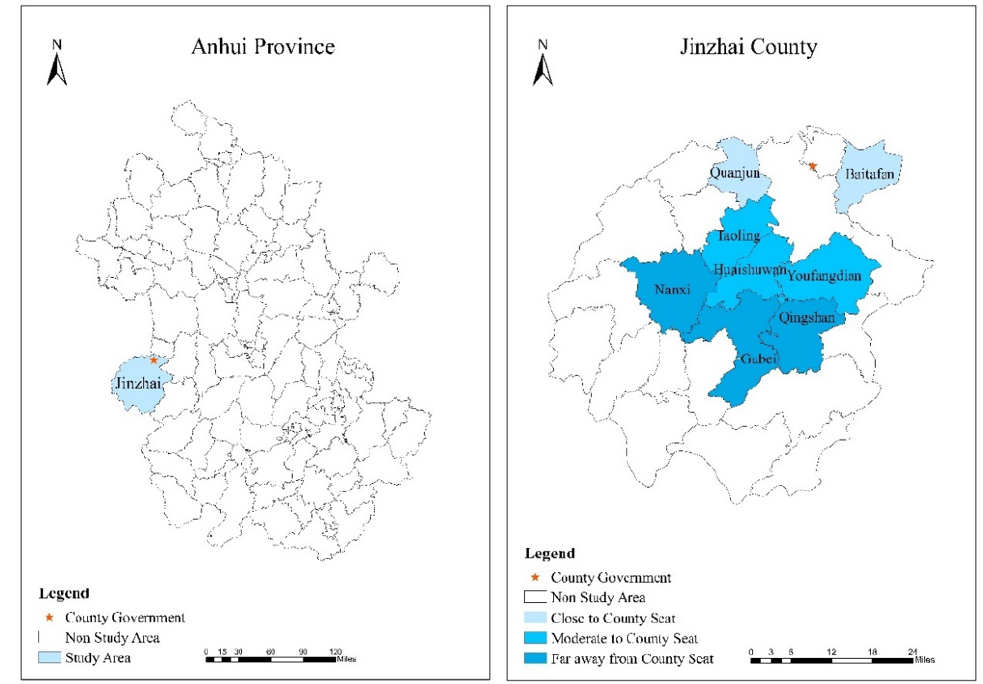
Figure 2. Location of the study areas.